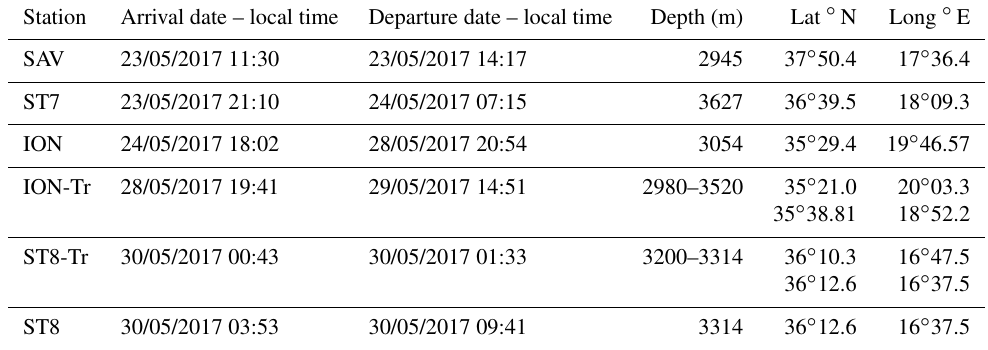
Table 1. Sampling in the Ionian Sea (see Fig. 1). Note that ST8 and ST8-Tr are considered to be one single station in the study.